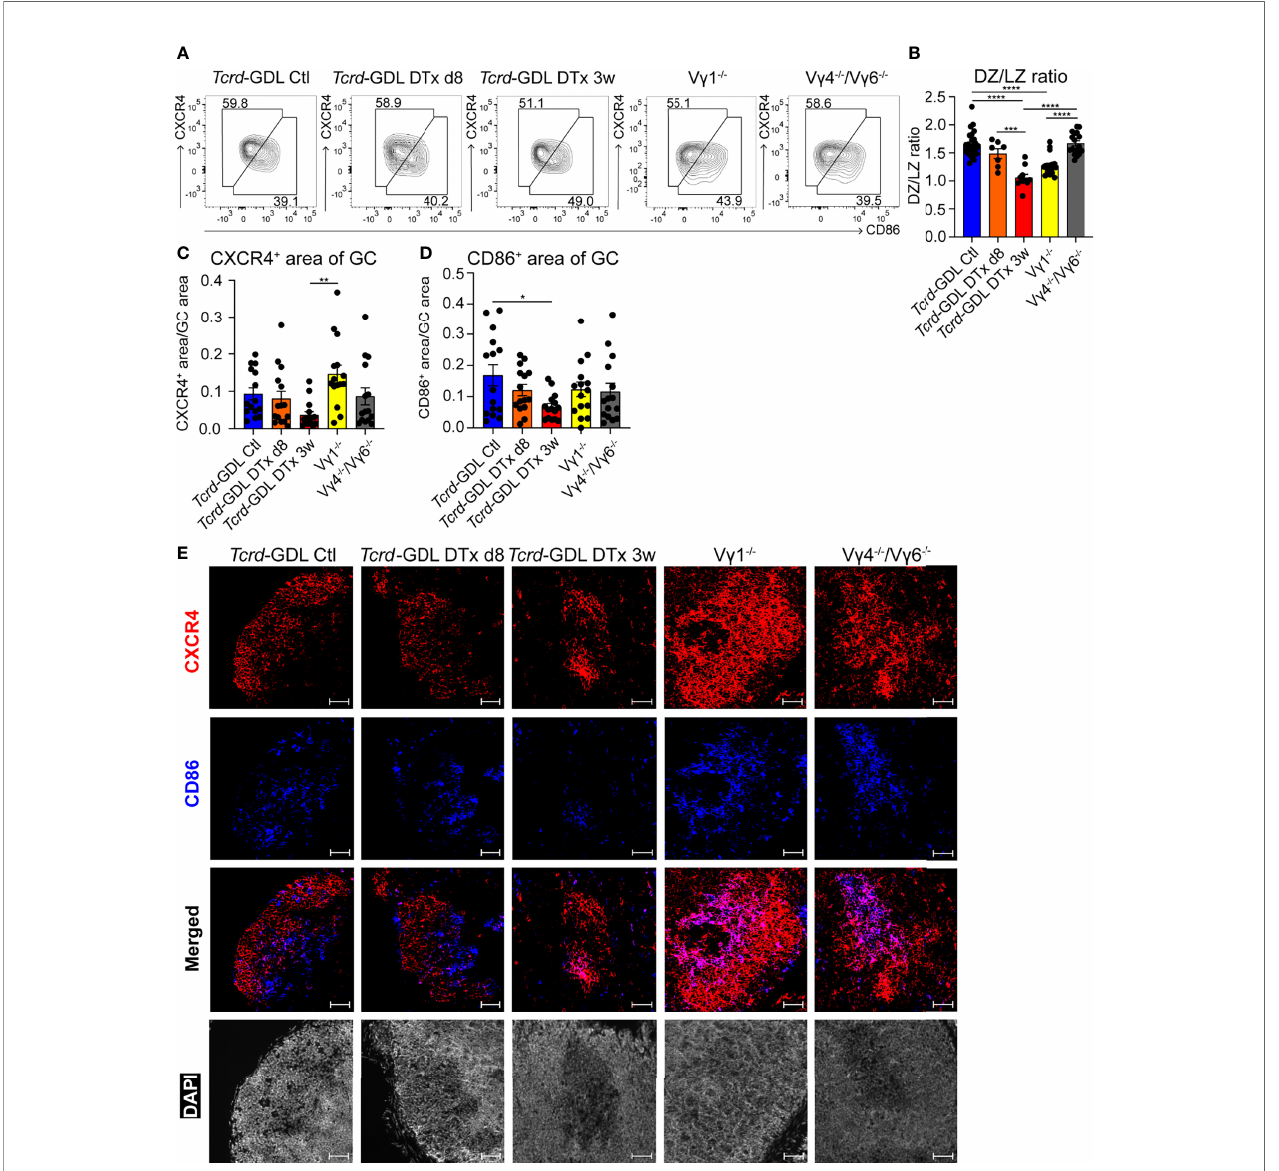
FIGURE 4 | gd T cells affect the structure of GCs. (A) FACS analysis of dark zone (DZ; CD19 + , CD138 − , GL7 + , CD95 + , CXCR4 high , CD86 low ) and light zone (LZ; CD19 + , CD138 − , GL7 + , CD95 + , CXCR4 low , CD86 high ) GC B cells of PPs. (B) Quanti fi cation of DZ/LZ ratio. Bar graph, mean ± SEM. n = 8 – 27 per group. ANOVA test was applied with Tukey post-hoc test. (C, D) Quanti fi cation of CXCR4 and CD86 area of GCs. For the quanti fi cation, sections from the proximal, medial, and distal part of the PPs were analyzed for each mouse. Each dot represents an individual cut. Bar graphs, mean ± SEM. n = 5 mice per group. ANOVA test was applied with Tukey post-hoc test. *P < 0.05, **P < 0.01, ***P < 0.001, ****P < 0.0001. (E) Fluorescence microscopy of frozen sections of PPs from non-depleted and gd T cell – depleted (8 days and 3 weeks) Tcrd -GDL, V g 1 − / − , and V g 4 − / − /V g 6 − / − mice stained with anti-CXCR4 (red), anti-CD86 (blue), and DAPI (white) to detect